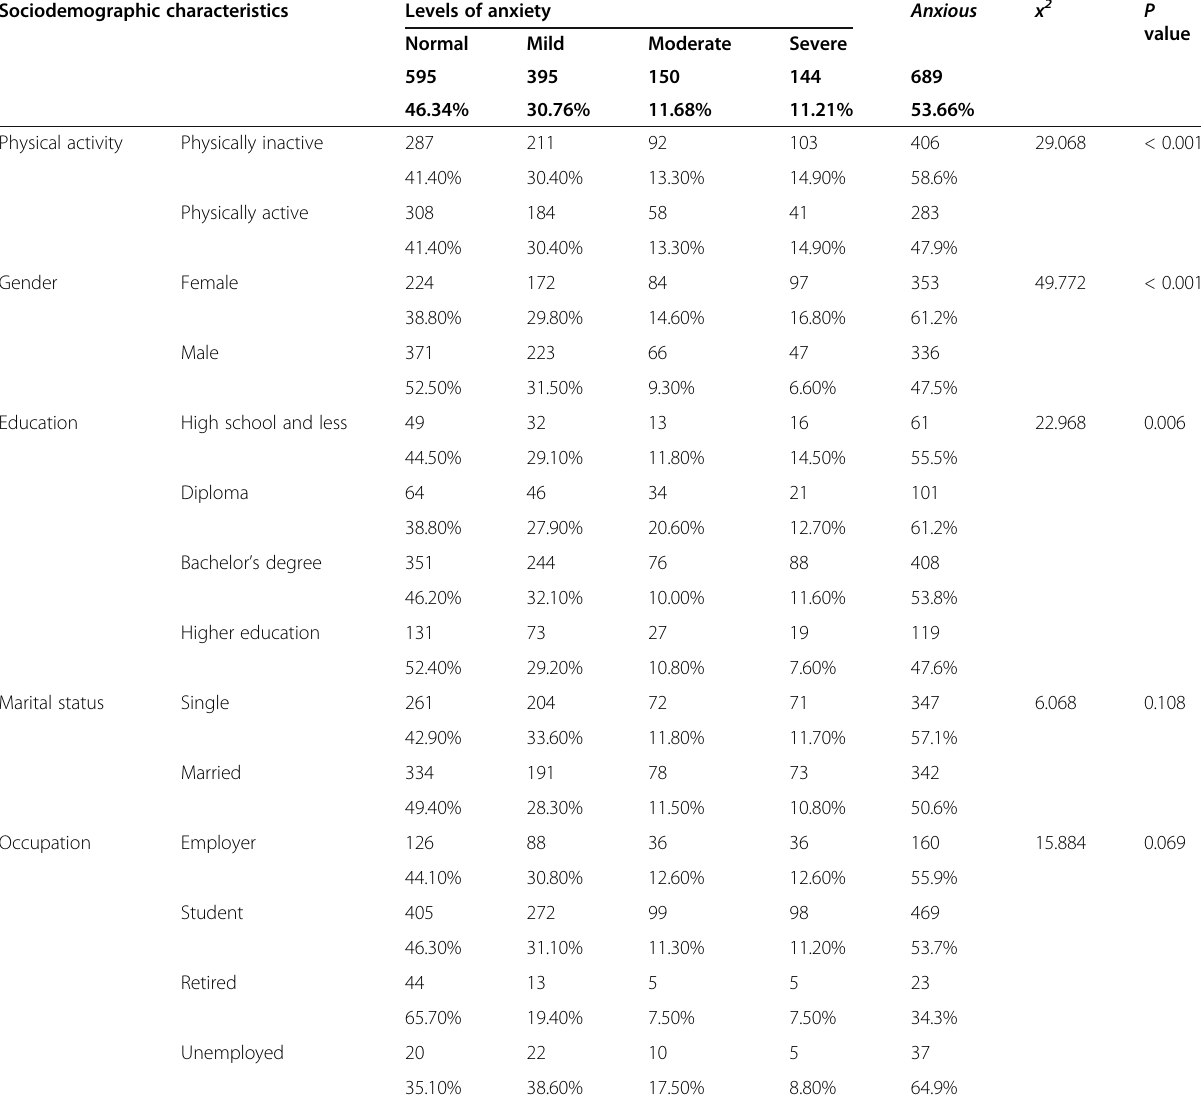
Table 2 Prevalence of generalized anxiety disorder (GAD-7) among groups during the outbreak of COVID-19 in Kuwait Sociodemographic characteristics Levels of